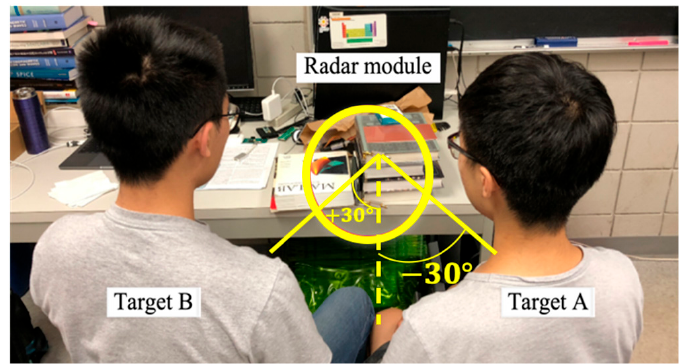
Figure 7. Experimental setup for detecting vital sign signals of two targets at different locations using MTM LWA-based homodyne radar sensor module at 24 GHz band [49].